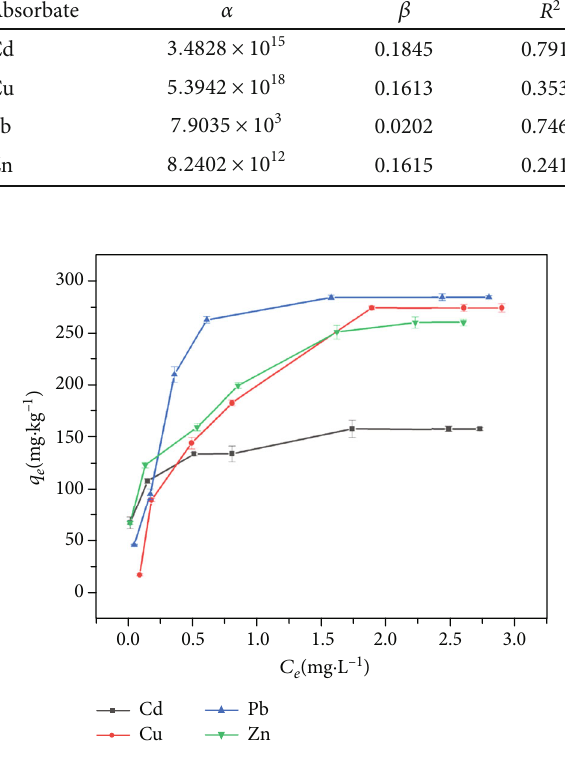
Figure 3: Adsorption isotherm on the original polypropylene ( V = 20 mL, temperature at 298 K, t = 48 h).